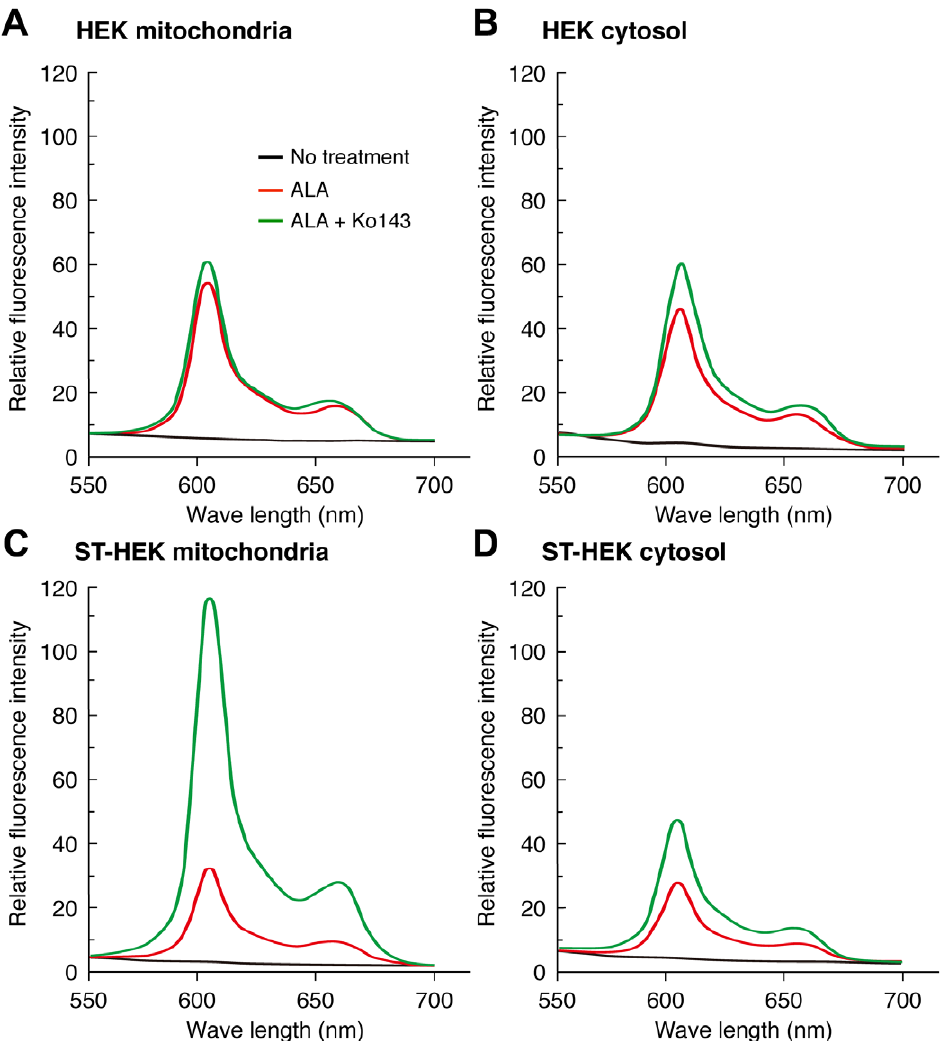
Figure 7. Mitochondrial ABCG2 regulates the level of ALA-mediated PpIX accumulation in mitochondria of ST-HEK cells. HEK and ST- HEK cells were incubated for 3 h with ALA in the presence or absence of 1 m M Ko143. After incubation, cells were washed with ALA-free medium and subcellular fractions were isolated as described in Materials and Methods. The fluorescence spectrum of each fraction was analyzed by a fluorophotometer. A representative histogram of three independent experiments is shown. The levels of PpIX were shown by black line (No treatment), red line (ALA without Ko143), green line (ALA with Ko143), respectively.